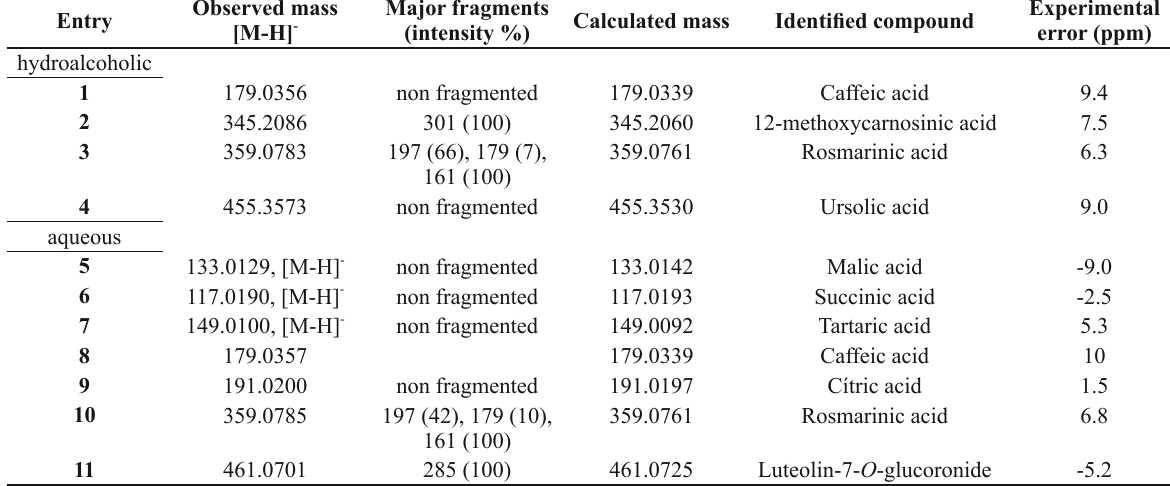
Main compounds identi fi ed by ESI-QTOF MS/MS analysis of the hydroalcoholic and aqueous extract of Salvia of fi cinalis